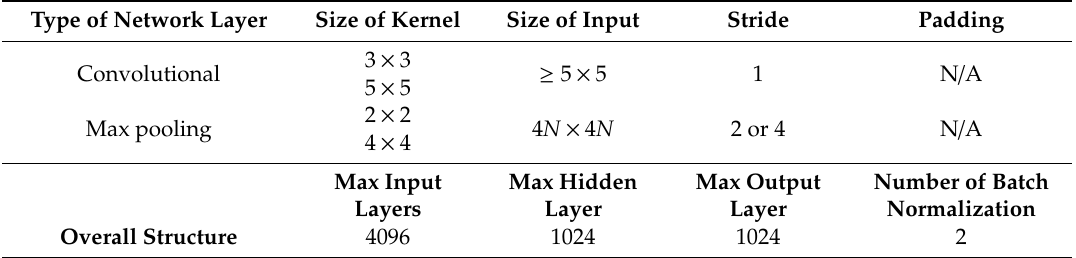
Table 1. The limitation of hardware resource constraints for implementing the CNN-based